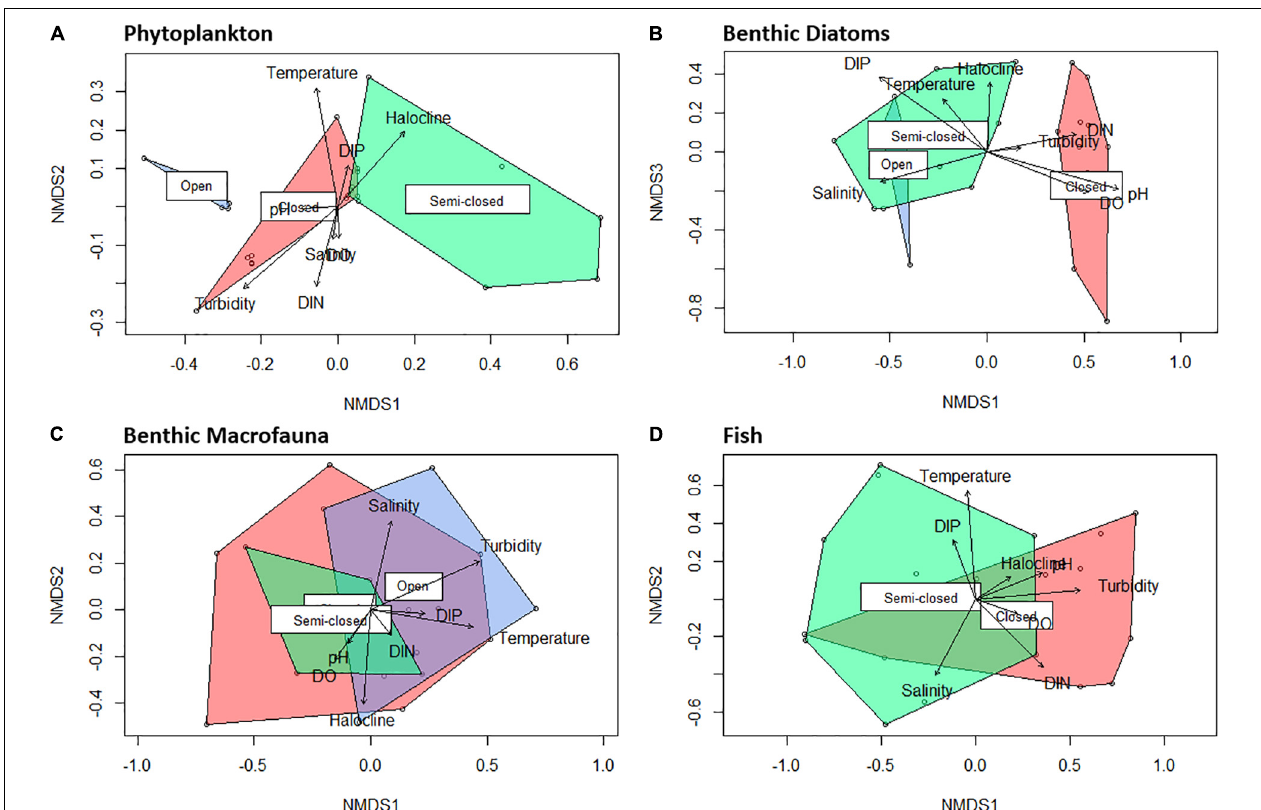
FIGURE 5 | Non-metric multidimensional scaling (NMDS) plots ( k = 3) of sampling stations based on phytoplankton [ (A) ; stress = 0.05; non-metric fit, r 2 = 0.998], benthic diatoms [ (B) ; stress = 0.12; non-metric fit, r 2 = 0.985], benthic macrofauna [ (C) ; stress = 0.08; non-metric fit, r 2 = 0.993], and fish [ (D) ; stress = 0.10; non-metric fit, r 2 = 0.990] group/species abundance, indicating the distinction between assemblages occurring during open (blue), semi-closed (green), and closed (red) mouth conditions.